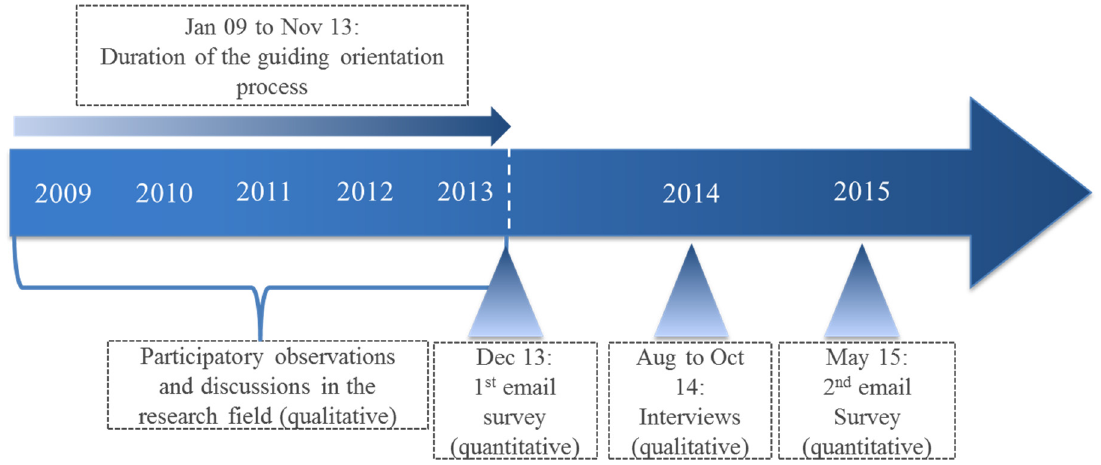
Figure 2. Conducted empirical research methods during and after the guiding orientation